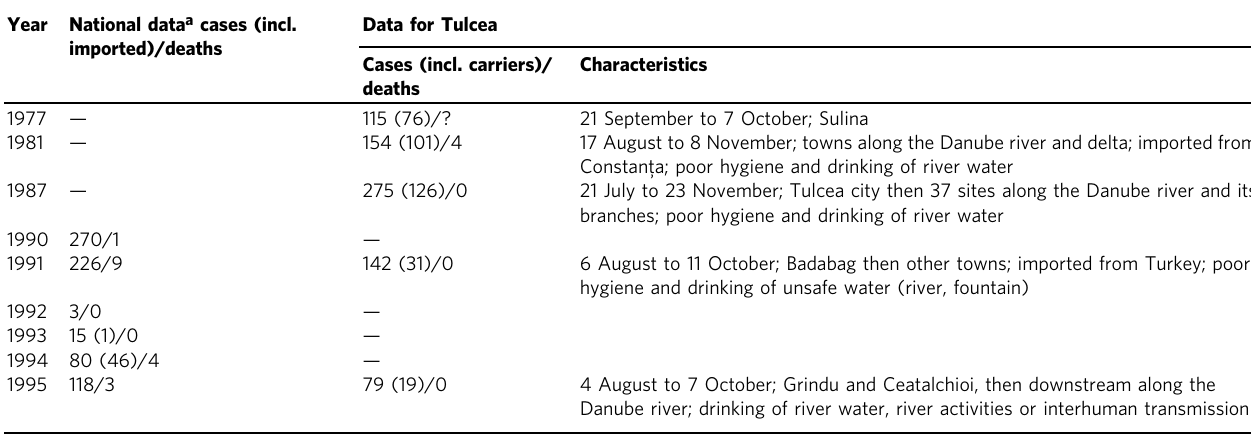
Table 4 Characteristics of the cholera cases in Romania, 1977 –